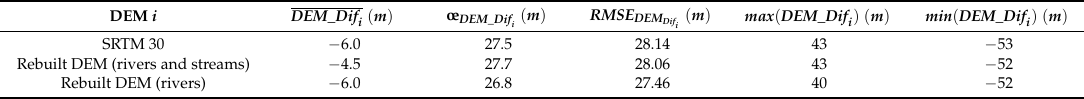
Table 1. Mean ( DEM _ Dif i ), standard deviation ( σ DEM _ Dif Table 1. Mean ( (cid:1830)(cid:1831)(cid:1839)_(cid:1830)(cid:2835)(cid:1858) (cid:3114) (cid:3364)(cid:3364)(cid:3364)(cid:3364)(cid:3364)(cid:3364)(cid:3364)(cid:3364)(cid:3364)(cid:3364)(cid:3364)(cid:3364)(cid:3364) ), standard deviation ( (cid:2026) (cid:3005)(cid:3006)(cid:3014)_(cid:3005)(cid:3036)(cid:3033) values of the differences DEM _ Dif i between the reference DEM and each DEM under values of the differences (cid:1830)(cid:1831)(cid:1839)_(cid:1830)(cid:1861)(cid:1858) (cid:3036) between the reference DEM and each DEM under analysis.